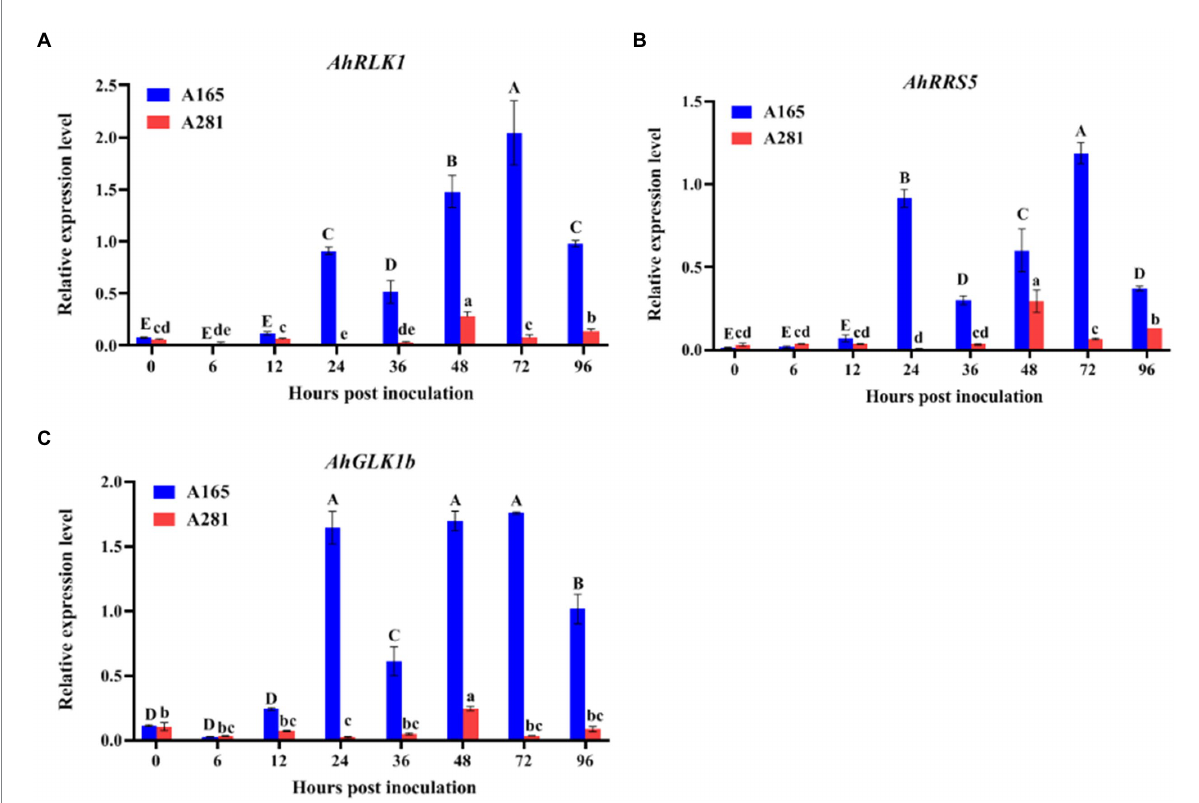
FIGURE 2 Expression analysis of AhRLK1 , AhRRS5 and AhGLKb in the leaves of A165 and A281 at 0, 6, 12, 24, 36, 48, 72, and 96 hpi with R. solanacearum HA4-1. Error bars represent standard errors. Different uppercases and lowercases indicate significant differences in the leaves of A165 and A281 at different timepoints according to ANOVA ( p < 0.05),